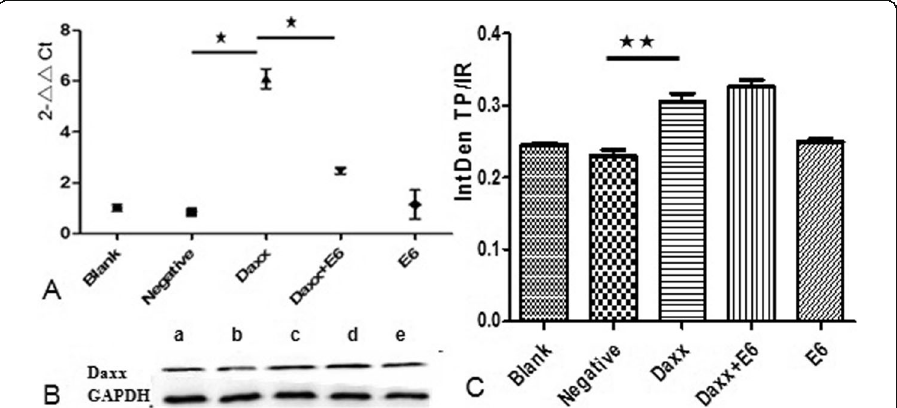
Fig. 2 Effects of HPV16 E6 on Daxx expression. A Relative quantification of Daxx RNA via quantitative PCR. Relative quantification of Daxx was evaluated using the double delta Ct ( ΔΔ Ct) method. ★ , p < 0.05. B Daxx protein expression evaluated via western blotting. (a) C33A cells without transfection; (b) C33A cells with empty vector transfection; (c) C33A cells with Daxx transfection; (d) C33A cells with E6 and Daxx co- transfection; (e) C33A cells with E6 transfection. C Integrated density values based on western blotting results. IntDen TP/IR describes the ratio of the integrated density of the internal reference to that of the target protein (IntDen IR/TP). ★★ , p < 0.01